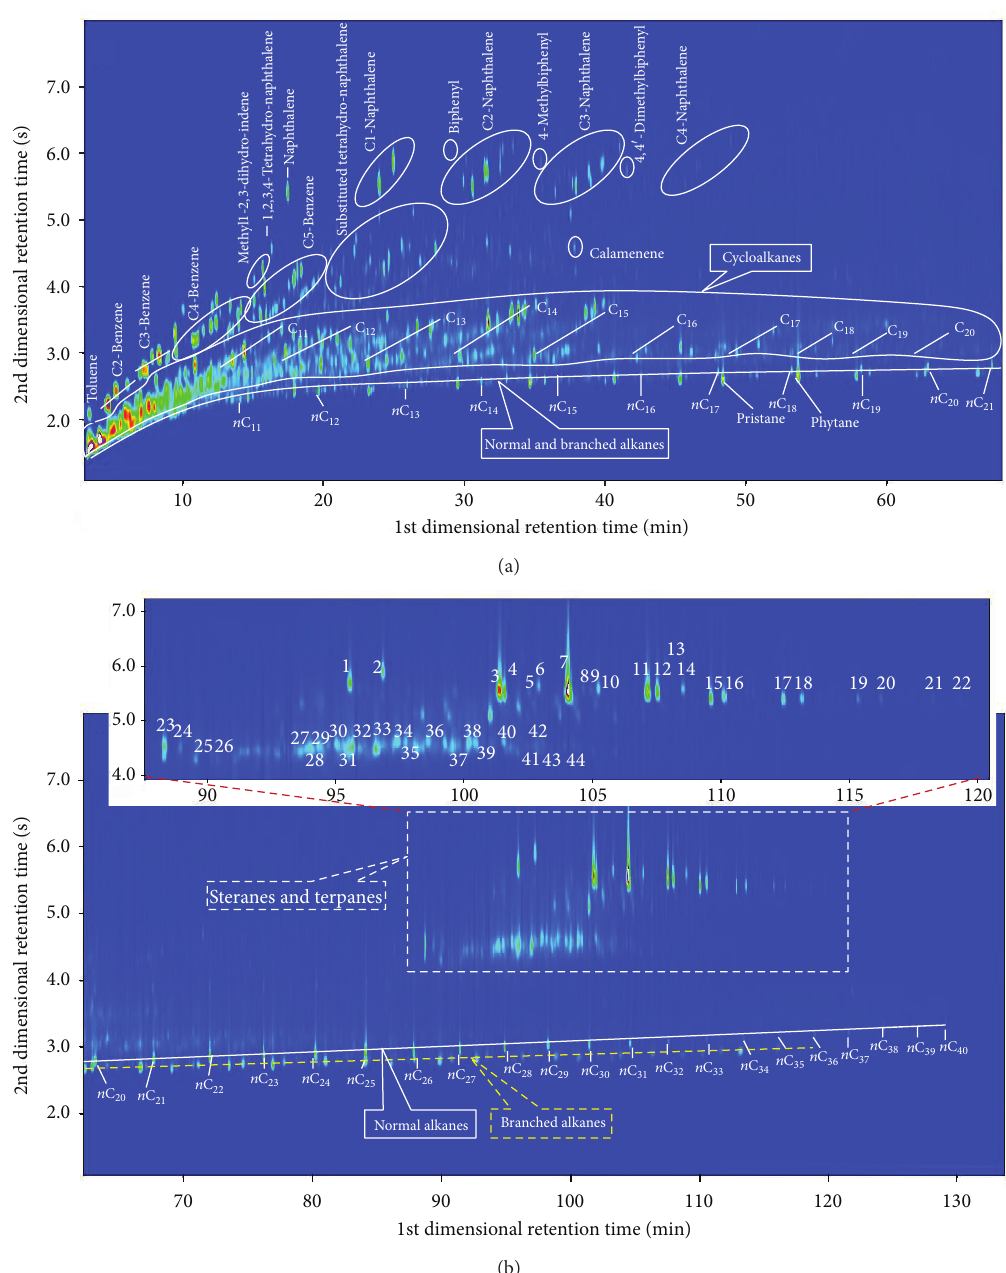
Figure 6: GC × GC/TOFMS total ion current chromatogram of a crude oil